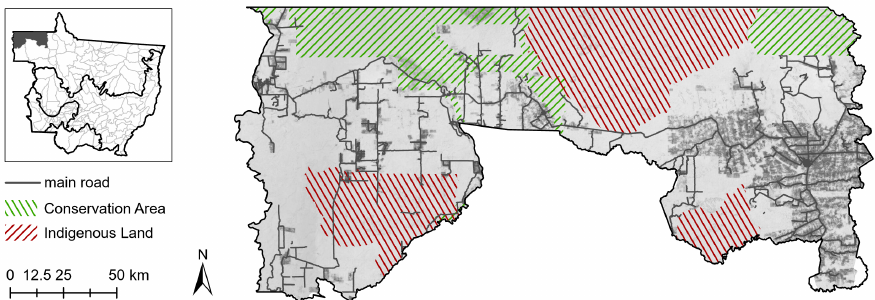
Figure 2. Municipality of Colniza (data from [47,52]. Service Layer Credits: Earthstar